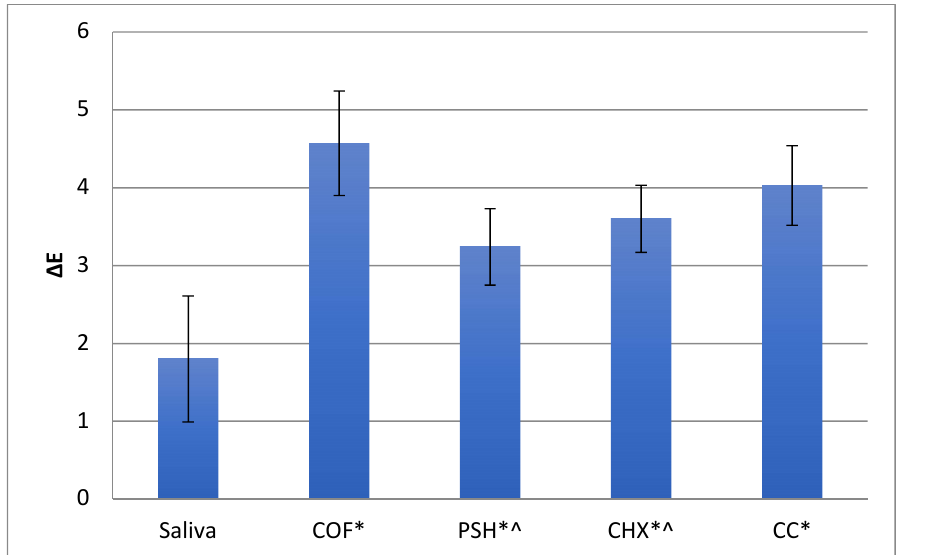
Figure 1. Mean and SD of ∆E values among the study groups. * Shows significantly different ∆E values compared to saliva; ^ shows significantly different ∆E values compared to coffee (COF).